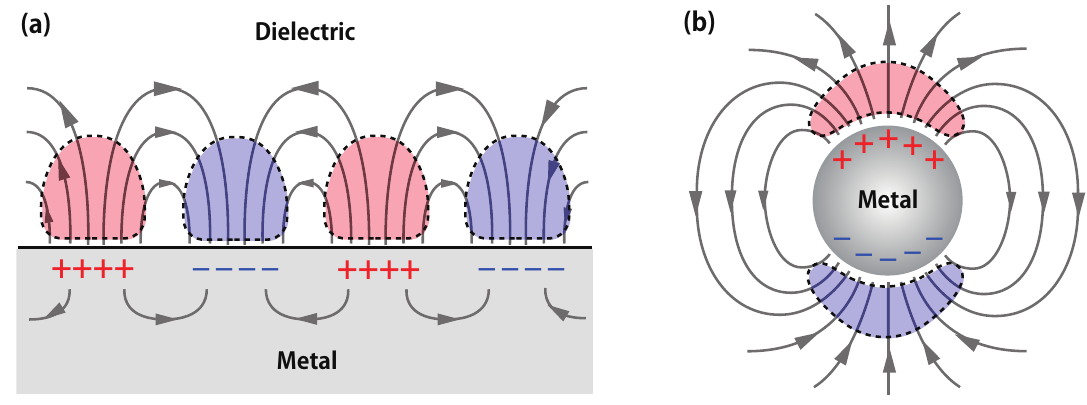
Figure 2. Surface plasmon (SP) resonances: ( a ) propagating SP; ( b ) localized SP. Electric charge distributions and lines of force are depicted. Regions enclosed with dotted lines indicate strongly resonant SP